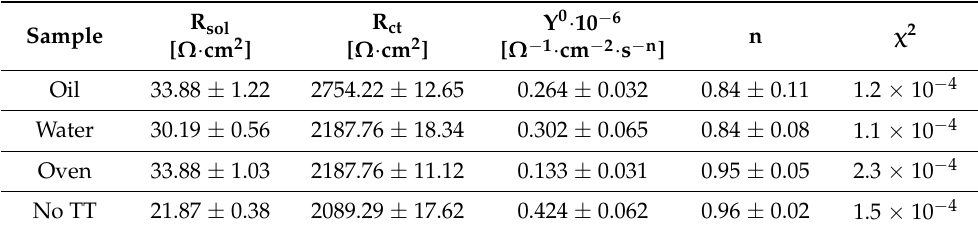
Table 4. Electrochemical parameters of equivalent